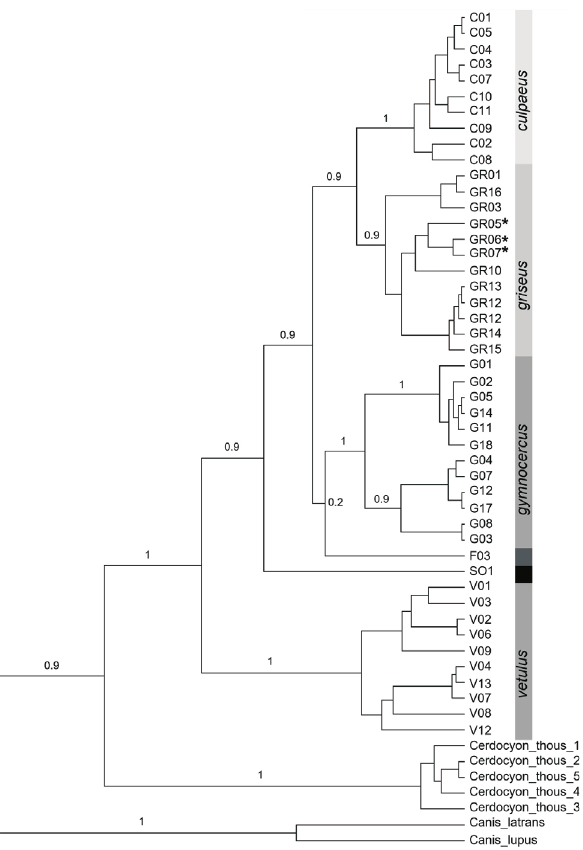
Figure 2 - Bayesian phylogeny (built with the GTR+G+I model) of 46 Lycalopex spp. haplotypes based on 588 bp of the mitochondrial DNA control region (only complete sequences were included in the analysis). Five Cerdocyon thous haplotypes were used as outgroups (see Figure S1 for results with additional outgroups). Labels are haplotype identification numbers (as coded in the Table S1: C – L. culpaeus ; GR – L. griseus ; G – L. gymnocercus ; F – L. fulvipes ; S - L. sechurae ; V – L. vetulus ). Values above branches indicate the Bayesian posterior probability for the adja- cent node (support values are shown only for the main clades retrieved in the phylogeny). Asterisks indicate haplotypes deriving from samples ini- tially labeled as L. gymnocercus , but whose phylogenetic position was nested within the L. griseus